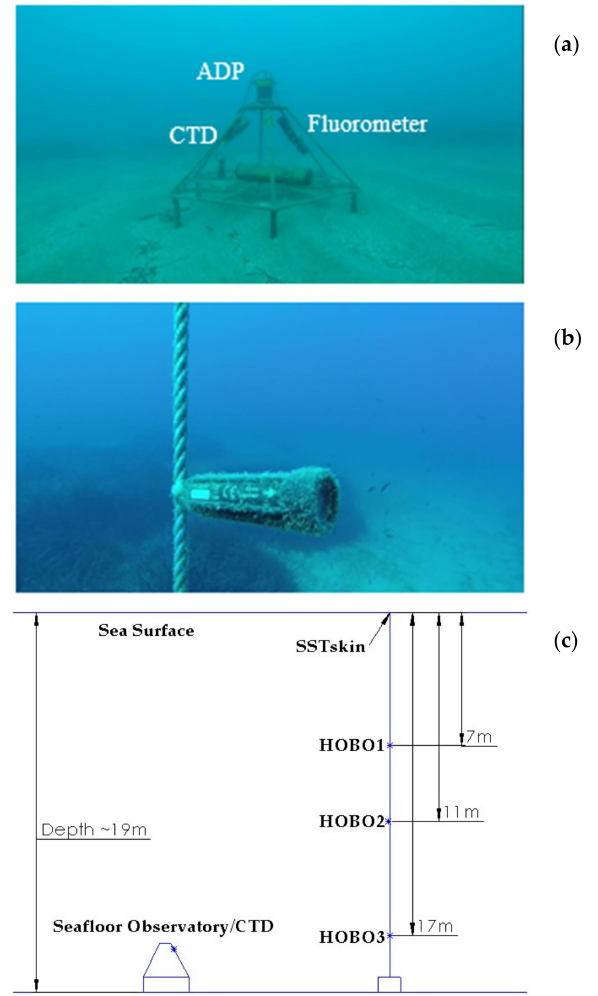
Figure 2. The temperature installations in the UBPC: ( a ) The Seafloor Observatory of the UBPC, bottom moored at approximately 19 m depth. The installed conductivity-temperature-density instrument (CTD) instrument, the Acoustic Doppler Profiler (ADP) and the Fluorometer are shown. ( b ) A deployed HOBO temperature sensor. The maximum length of the sensor is 11.5 cm and maximum diameter 3 cm. ( c ) A drawing of the installed temperature instruments. The distance between the CTD and the HOBO3 is 10